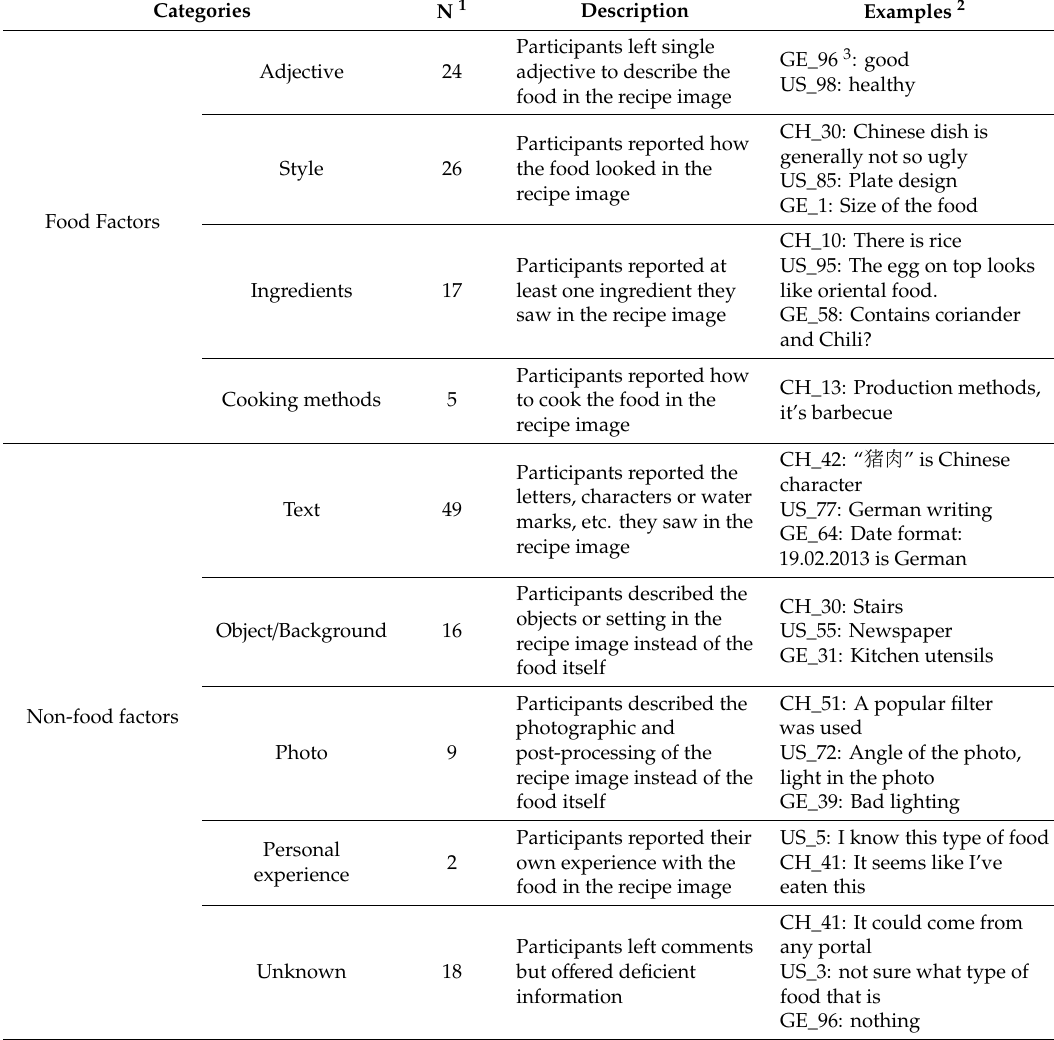
Table 5. Coding scheme for factors reported by